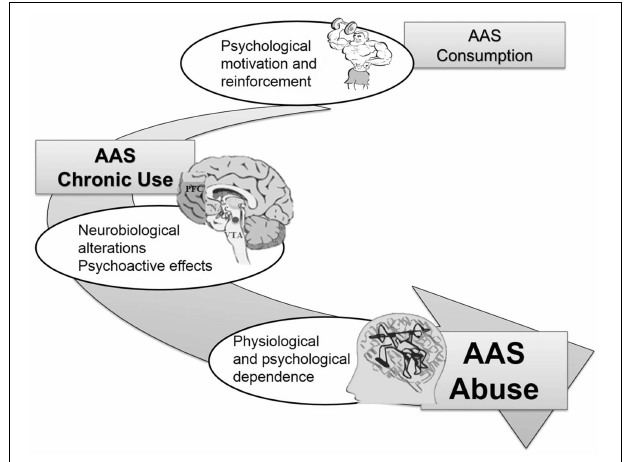
FIGURE 1 | Main clinical observations linking AAS consumption to AAS